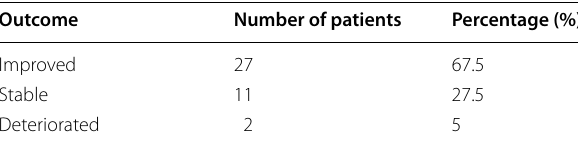
Table 3 Clinical outcome Outcome